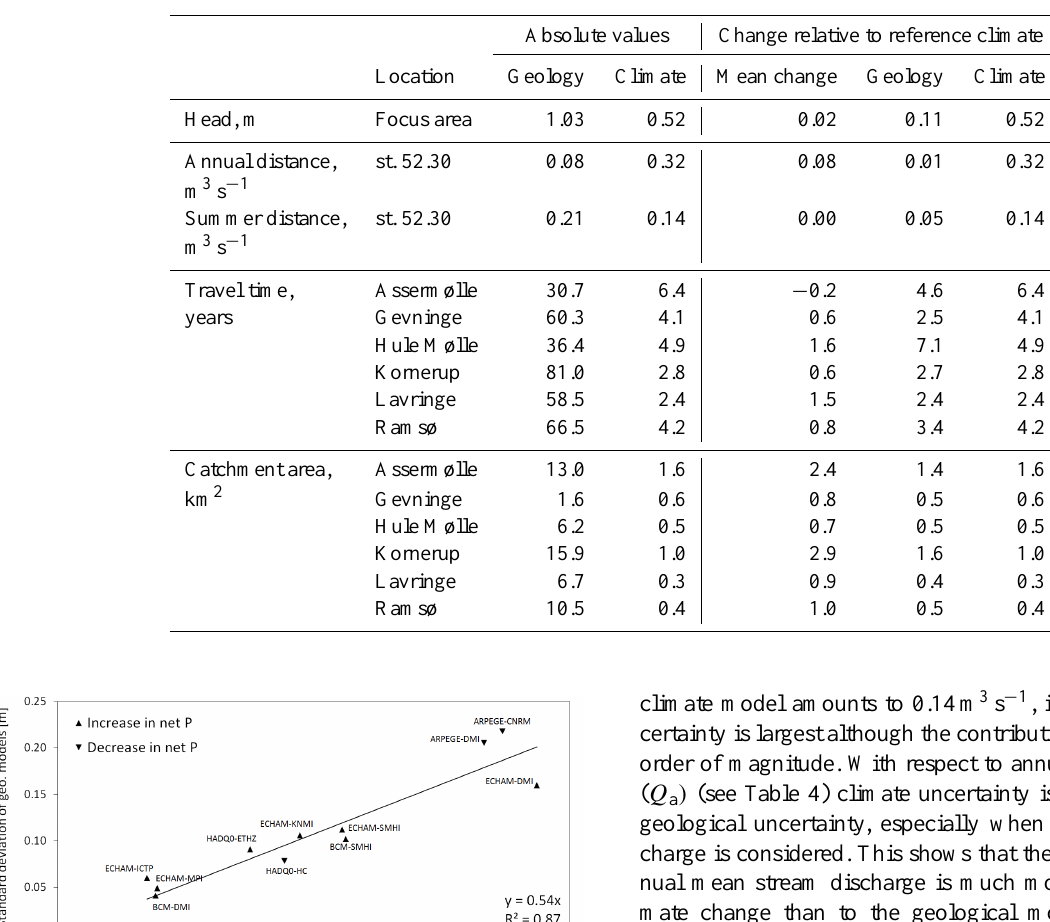
Table 4. Results of variance analysis with respect to climate models and geological models on (1) absolute mean values and (2) changes in mean values compared to results obtained using reference climate with respect to hydraulic head, discharge (annual and summer distance), travel time and catchment area. All variance components (columns denoted “Geology” and “Climate”) are presented as standard deviations. The column “Mean change” denotes the projected mean change.